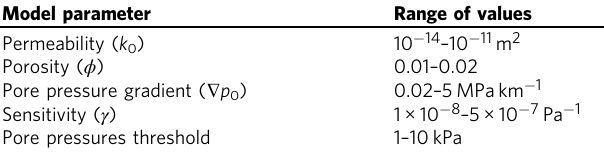
Table 2 Ranges of the model parameters where soliton pore- pressure waves may propagate with speeds between 1 and 200 km h − 1 under plausible conditions for subduction zones where RTMs are observed Model